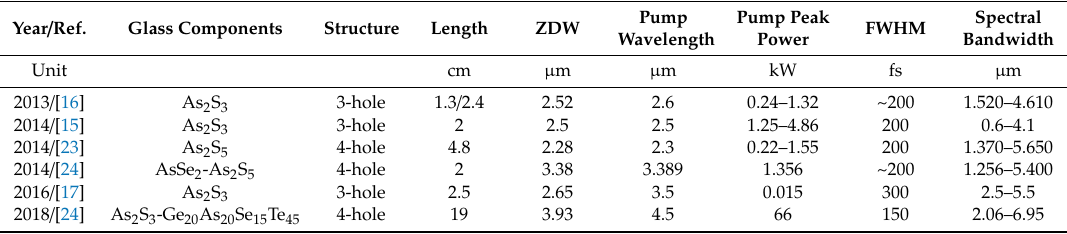
Table 1. Overview of previously published